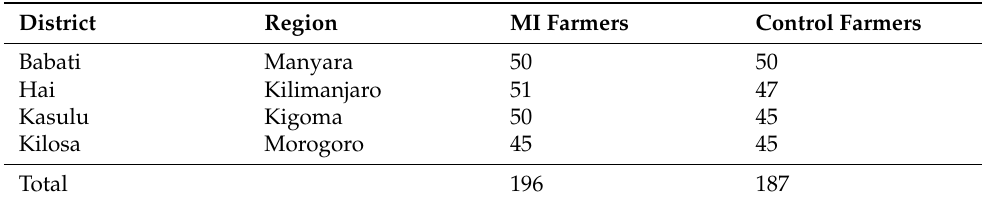
Table 1. Distribution of sample size, micro-investing (MI) and control farmers, across four districts in